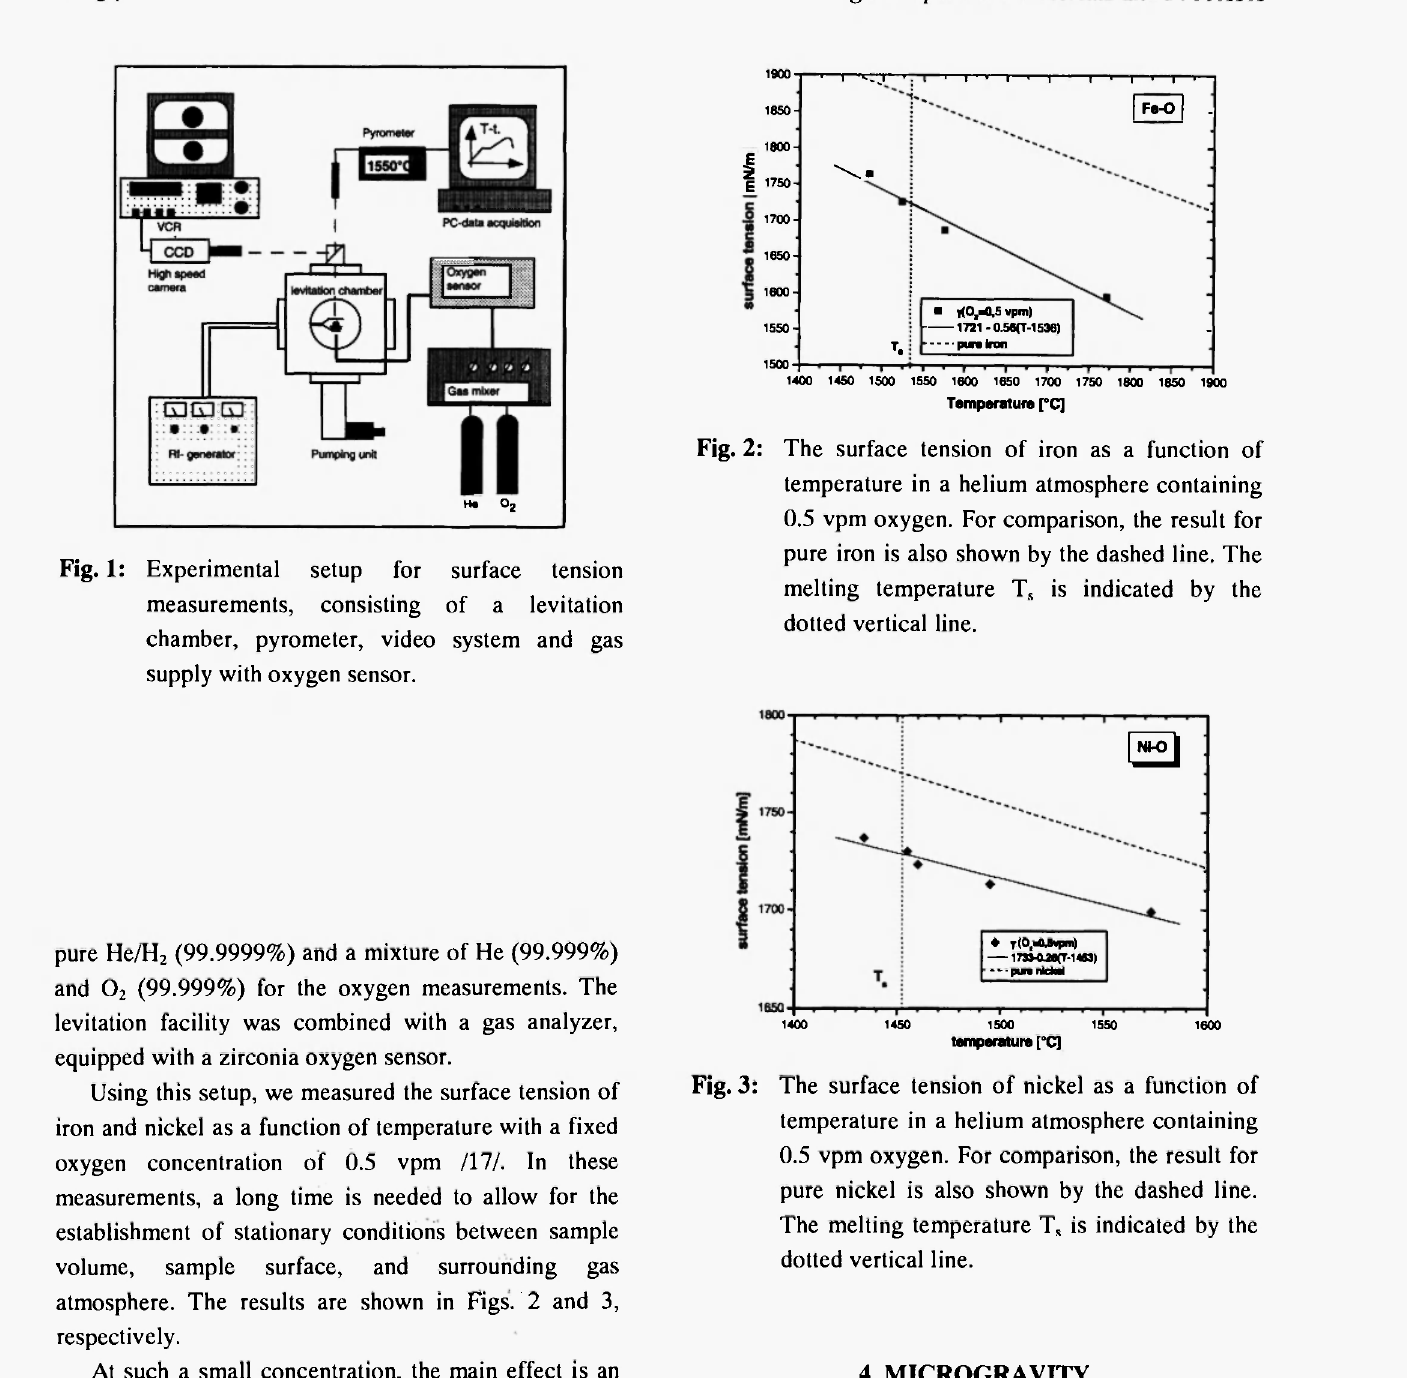
1400 1450 1500 1550 1600 1650 1700 1750 1800 1850 1900 Temperature [°CJ Fig. 2: The surface tension of iron as a function of temperature in a helium atmosphere containing 0.5 vpm oxygen. For comparison, the result for pure iron is also shown by the dashed line. The melting temperature T s is indicated by the dotted vertical line.